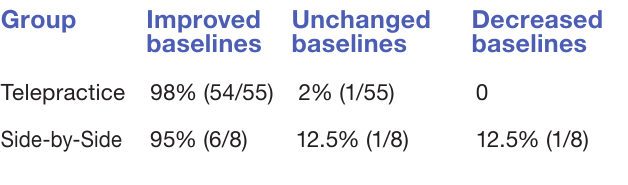
Table 5. Side-by-side group baseline and post-intervention percent correct data levels for target sounds.